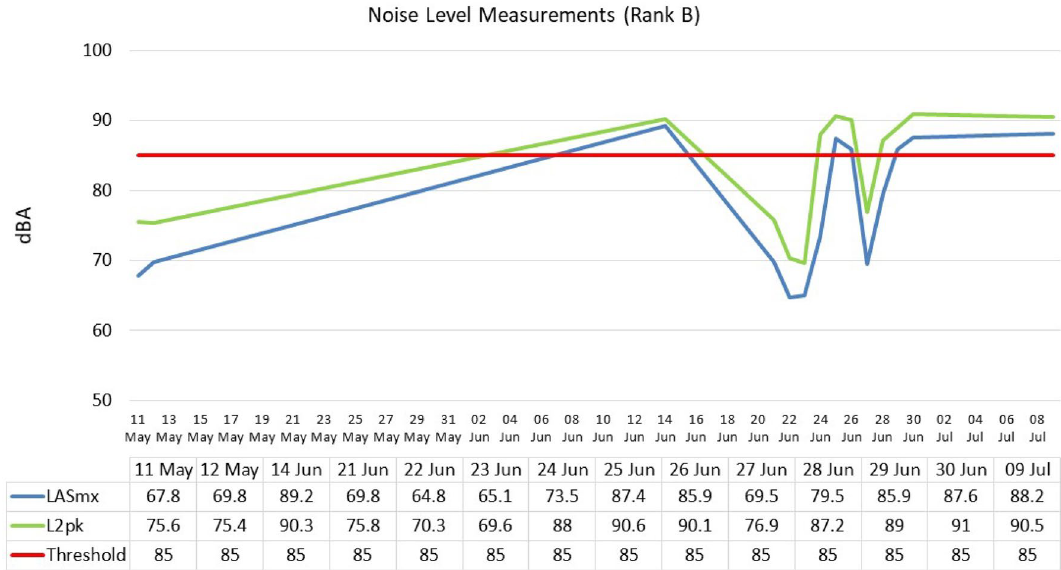
Figure 5. Noise measurements in Rank B.